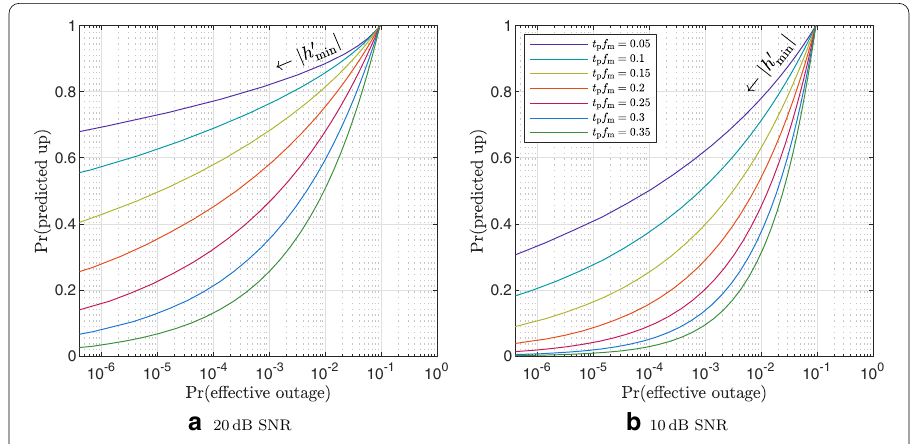
Fig. 12 Analysis of the outage prediction performance. F = 10dB , (cid:31) tf m = 0.05 and M =